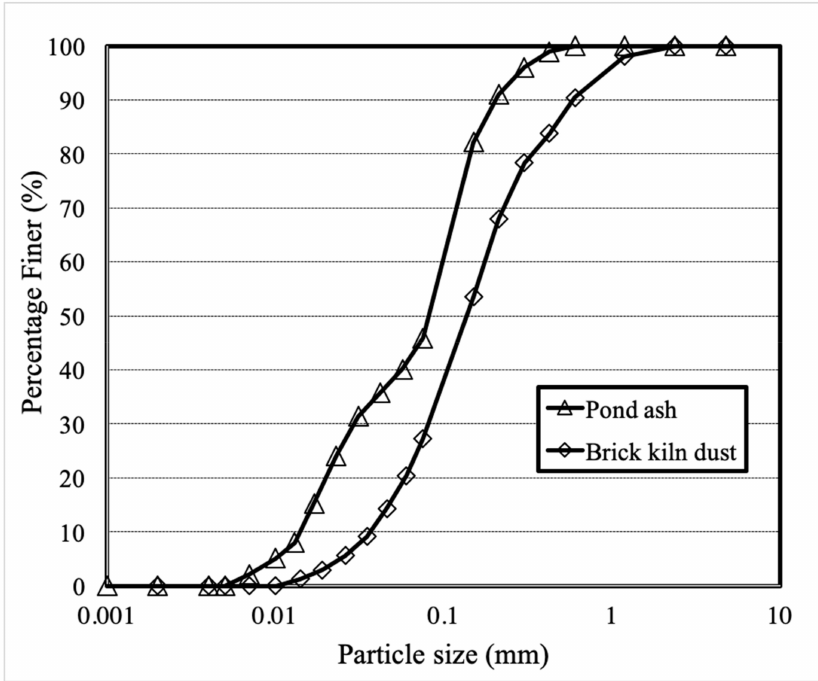
Figure 1. Particle size distribution curve for pond ash and brick kiln